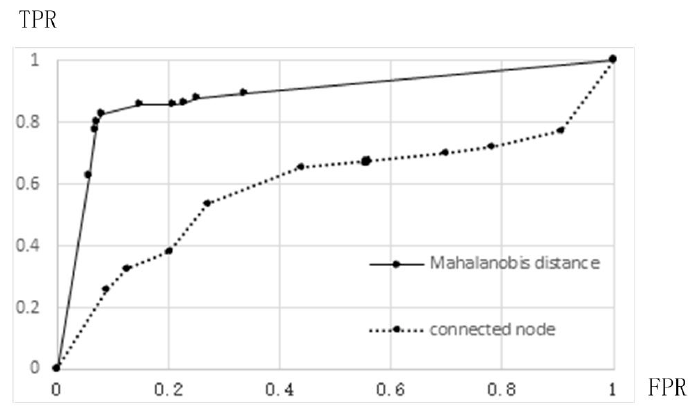
Figure 9. Comparison of the ROC curve when k = 4.